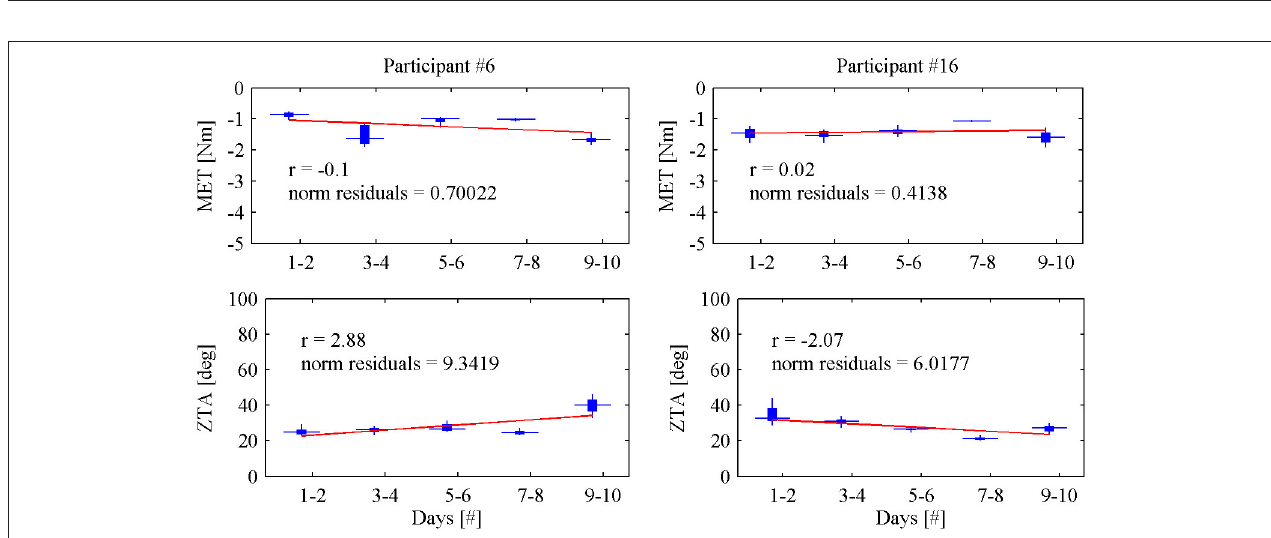
FIGURE 3 | Overall therapy effectiveness. (A) Maximum extension torque ( MET ) in the first (blue) and last (red) day of treatment. (B) Zero-Torque Angle ( ZTA ) in the first (blue) and last (red) day of treatment. The left panels show the median values and 90% confidence interval for each subject. The right panel reports the inter-subject median value and confidence interval.